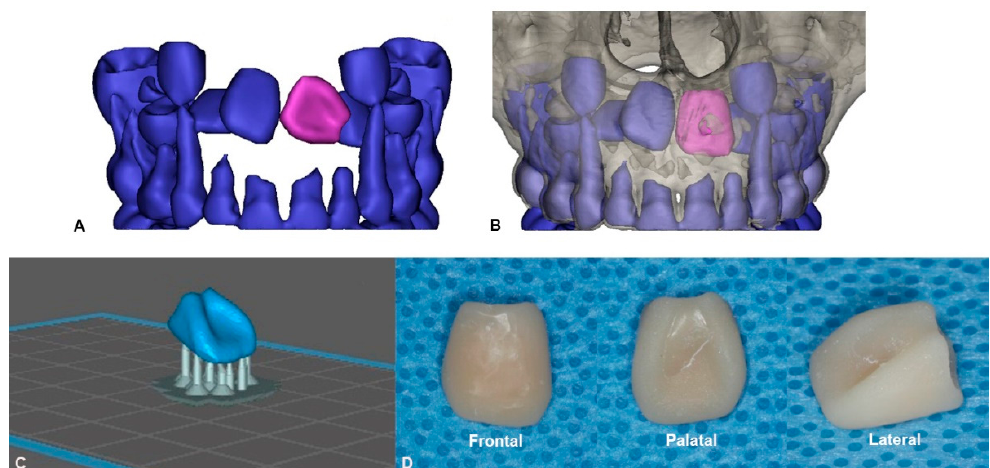
Figure 2. Virtual images of the central incisor, ( A ) Preoperative 3D image of the maxillary left central incisor (purple); ( B ) Images of the tooth (purple) moved to the planned position after surgery; ( C ) Images prepared for 3D printing using CHITUBOX ® (CBD-Tech, Shenzhen, China); ( D ) 3D printed replica views from various directions.